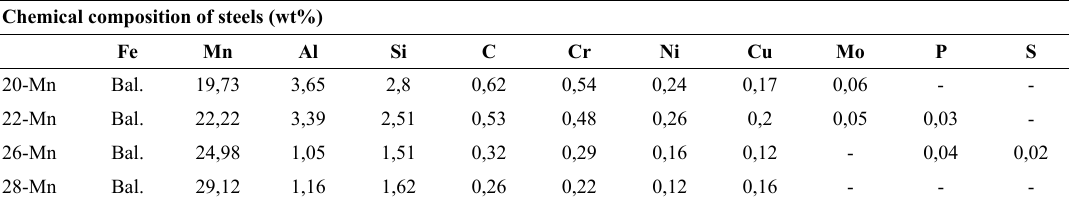
cell with platinum counter electrode, 5A current and 18V voltage for 8 7 . To reveal the microstructure, a solution of 40% nitric acid + 60% distilled water was used for 20 seconds 7 . Microstructural analysis was performed using the Zeiss ® optical microscope model AX10.It has been applied the EBSD sample preparation for the tests, the same way as in the metallography test, with a difference in polishing, which was made with alumina 1 micron and 0.5 for steels with 20% to 22% manganese; in the case of 26% and 28% manganese steels, 1 micron alumina was used and then the electrolytic polishing was performed for 60 seconds using a solution of 50% glycerol + 25% ethyl alcohol + 25% phosphoric acid 7 . Microstructural analysis was performed on Philips Scanning Electron Microscope XL-30, EBSD OXFORD / HKL Channel Table 1. Chemical composition of high manganese steel models obtained by X-ray fluorescence. Source: